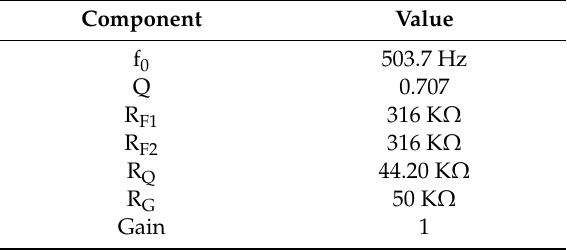
Table 3. Values obtained for the low-pass filter of 500 Hz with the Filter 42